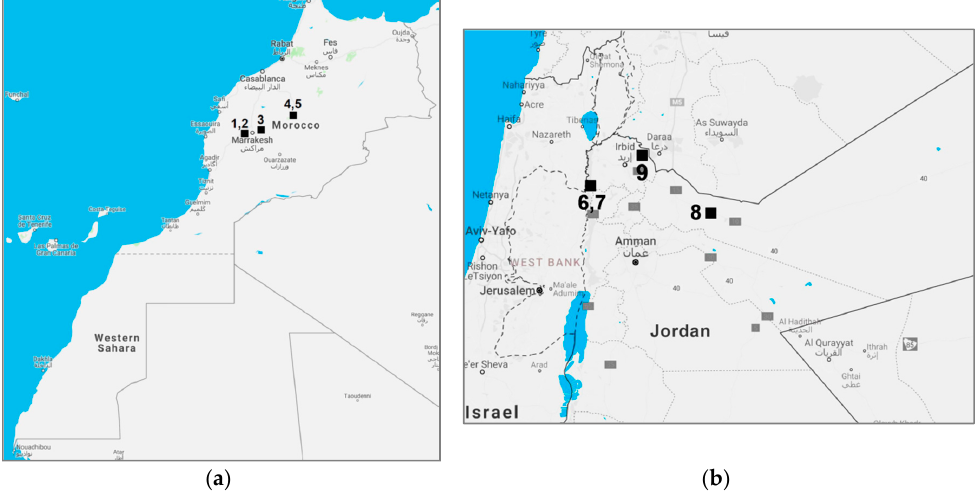
Figure 2. Locations of experimental sites in ( a ) Morocco and ( b ) Jordan (Google Maps, 2018a, 2018b). In Morocco, the sites were located in the Marrakech (1–3) and Beni Mellal (4, 5) regions. In Jordan, the sites were in the Northern Jordan Valley (6, 7), Al-Mafraq (8) and Ramtha (9) regions.